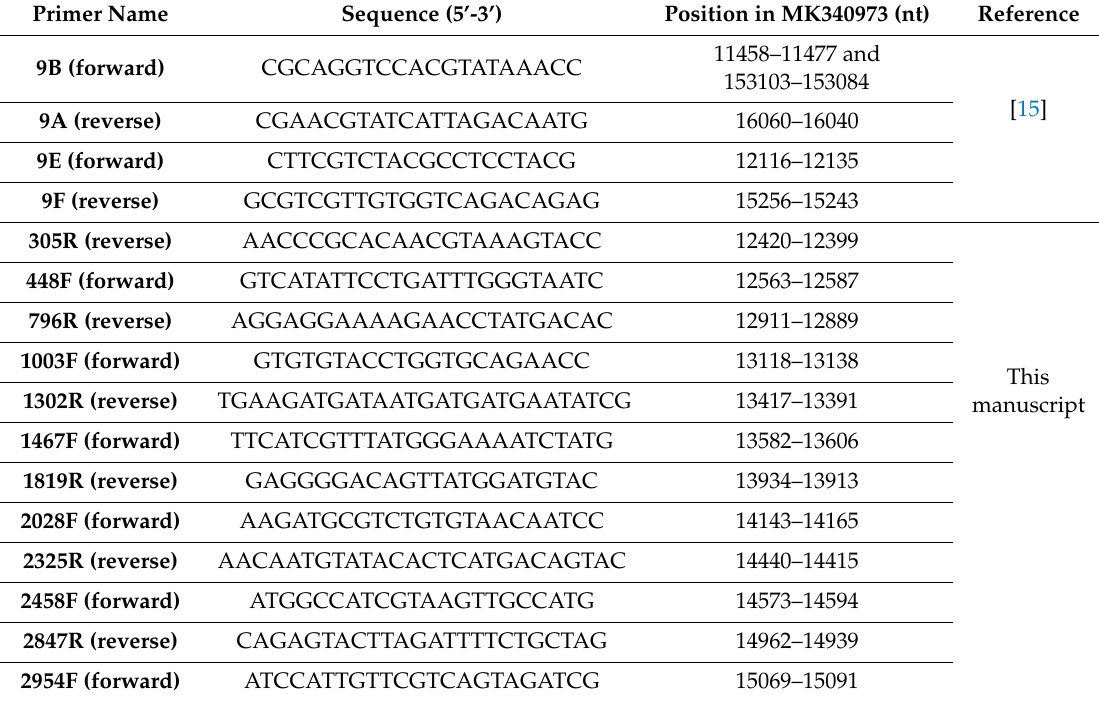
Table 1. Summary of oligomers used for amplification and